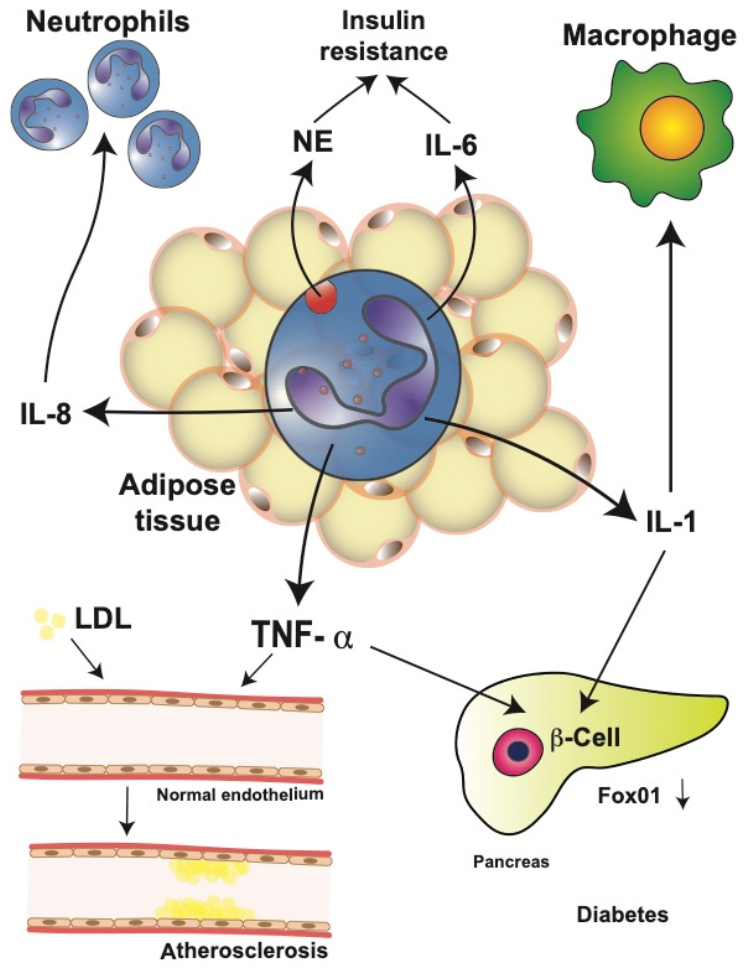
Figure 5. Neutrophils in obesity-related complications. Neutrophils in obese adipose tissue release large amounts of interleukin (IL)-1 β , IL-6, IL-8, and tumor necrosis factor alpha (TNF- α ). These cytokines have important systemic effects leading to obesity-related complications. IL-8 recruits more neutrophils into the adipose tissue, creating an amplification cycle. Neutrophil elastase (NE) and IL-6 contribute to the development of insulin resistance by impairing insulin signaling. IL-1 β is an important activator of macrophages in multiple parts of the body. Furthermore, IL-1 β , together with TNF- α in pancreatic islets, induces β cell dedifferentiation by downregulating transcription factor Fox01, which regulates β cell proliferation. Together, these events may result in type 2 diabetes mellitus. In addition, TNF- α can alter the adhesion function of endothelial cells by inducing increased low-density lipoprotein (LDL) uptake. These changes have been associated with the progression of atherosclerosis.